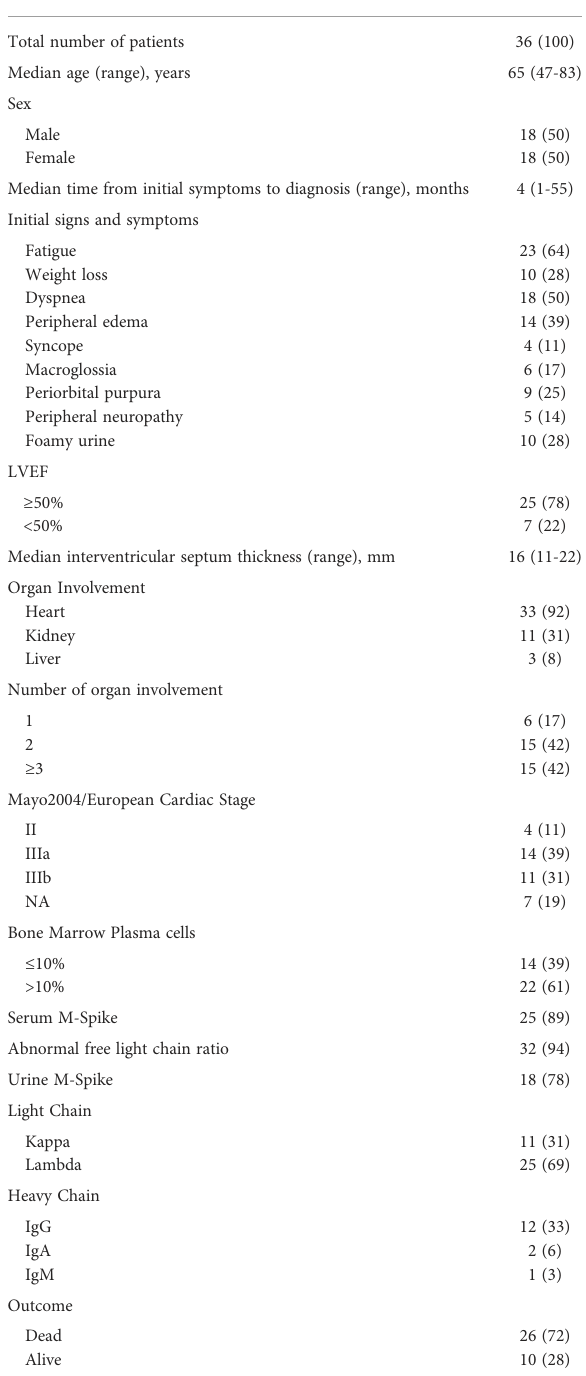
TABLE 1 Baseline patients ’ characteristics and